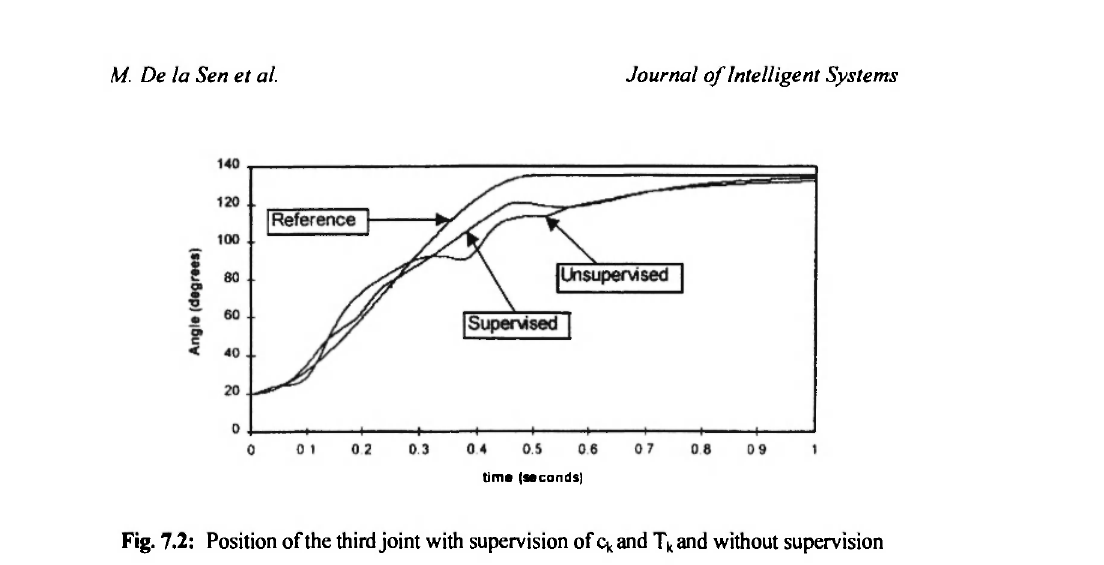
Fig. 7.2: Position of the third joint with supervision of q< and T k and without supervision